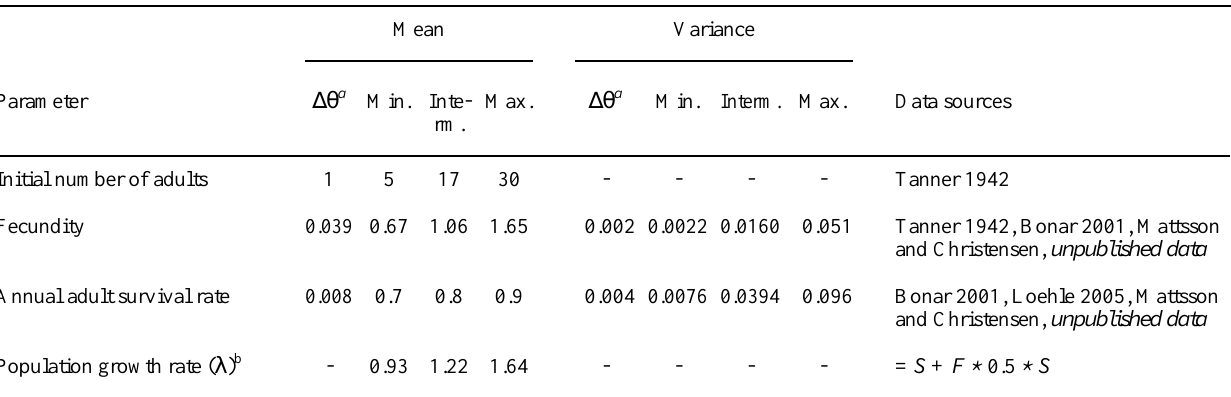
Table 1. Minimum, maximum, and intermediate input values used in perturbation analysis for a stage- based population model that predicts extinction rates of large-bodied woodpeckers. Instantaneous rate of population growth ( l ) represents the expected population trajectory in the absence of stochasticity in the model. Mean Variance D q a Min. Inte rm.